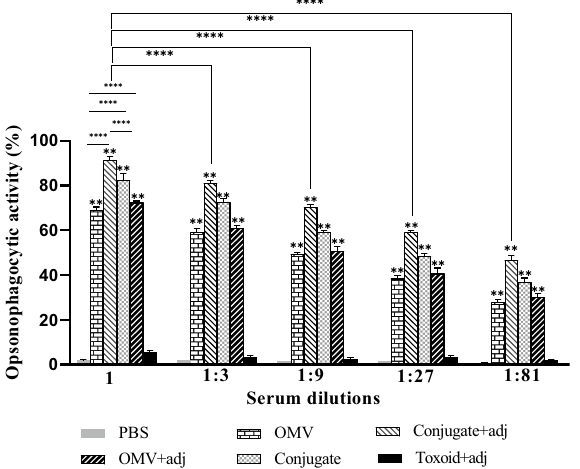
Figure 7. Opsonophagocytic activity against PAO1 in mice immunized with PA-OMVs-DT + adjuvant. Mouse sera from the vaccinated and control groups (n = 5) were pooled to determine the opsonophagocytosis. Multiple comparisons among different groups were analyzed using one-way ANOVA. Data represent the means ± SD of the percentage of killing bacteria phagocytized compared to PBS-immunized samples. ** P < 0.01 and *** P < 0.001were considered statistically significant,